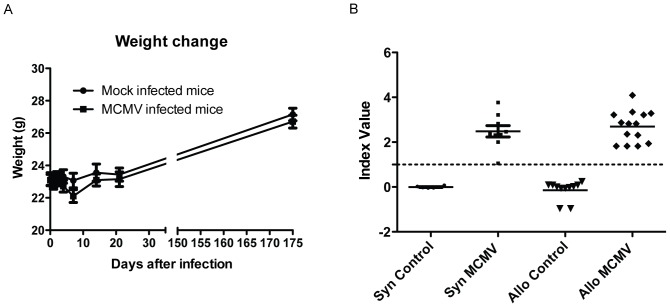
Weight change after MCMV infection and MCMV serology testing.MCMV infection was done by intraperitoneal injection of 3×104 PFU purified Smith strain in naive BALB/c mice and another set of mice were mock infected as control. (A) Weight change was monitored following infection for 25 weeks; n per group = 28 (MCMV) and 24 (mock); Data are presented as mean. (B) 25 weeks following infection, animals were analyzed for anti-MCMV IgG seropositivity as indicator for MCMV infection. Data shown present the index value with ≥1 determined as positive, data points for individual mice are shown.